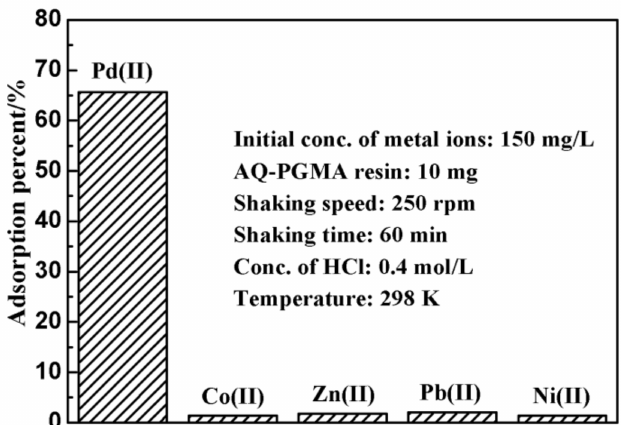
Figure 6. Effect of coexisting ions on the adsorption of Pd(II) by AQ-PGMA.